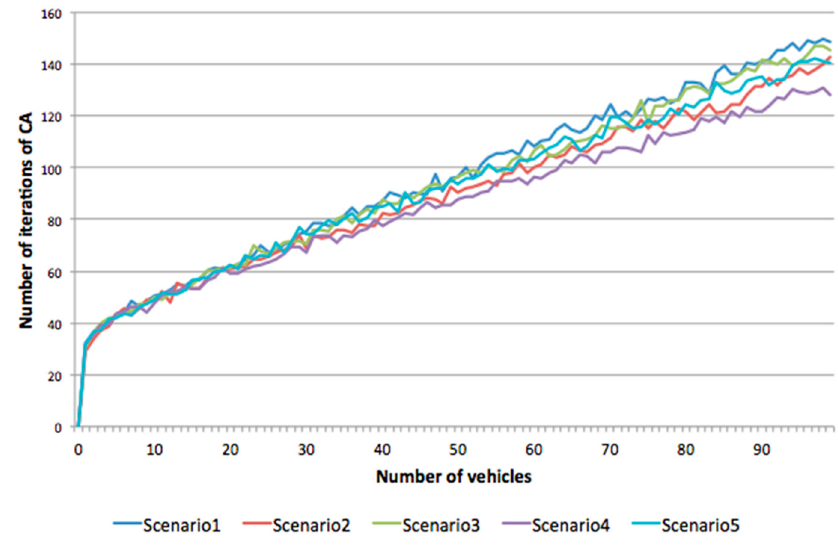
Figure 16. Examining the impact of the number of vehicles moving on snowy surfaces on roundabout capacity, as per various traffic scenarios.